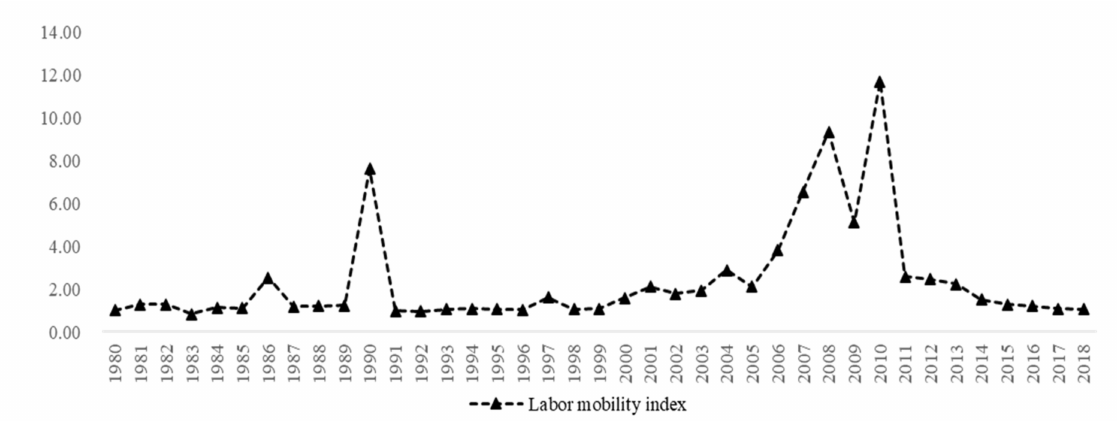
Figure 1. The trend of the labor mobility index and the annual average inflow of floating population in China from 1980 to 2018. Note: According to the calculation formula of net mobility rate in the Section 3.2.2, the annual results of each province were taken as the natural index, and then the annual average value of the whole country was calculated to represent the inflow index.